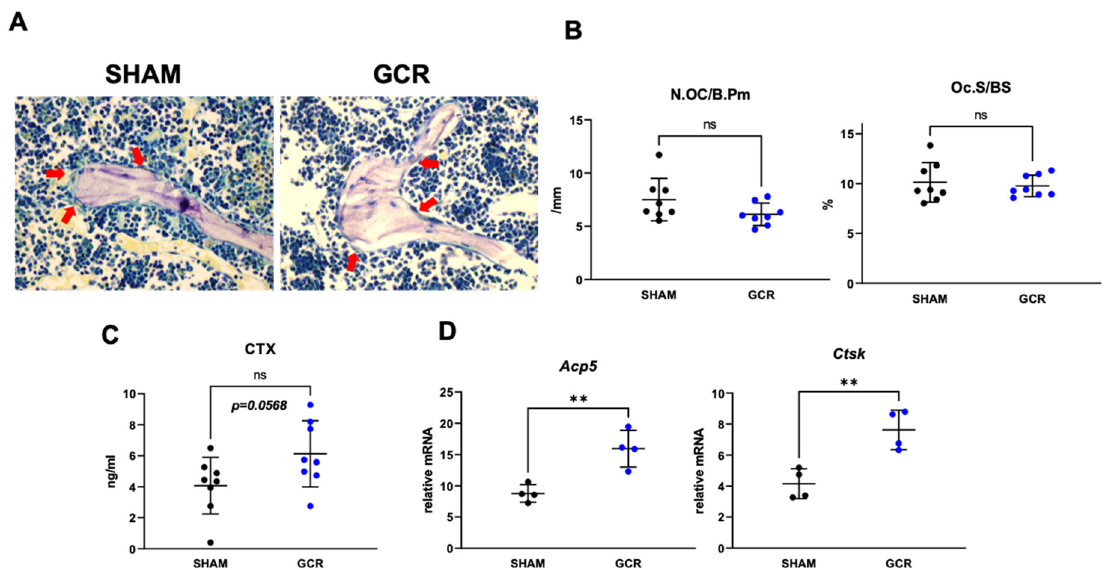
Figure 3. Late OC differentiation markers in serum were increased when mice were exposed to 0.5 Gy GCR. ( A , B ) GCR or sham exposed adult male BalbC mice did not show any differences in the number (N.OC/BPm; osteoclast number per bone perimeter) of OCs on the endocortical bone surface 3 months after GCR exposure. Femoral trabecular bone histology